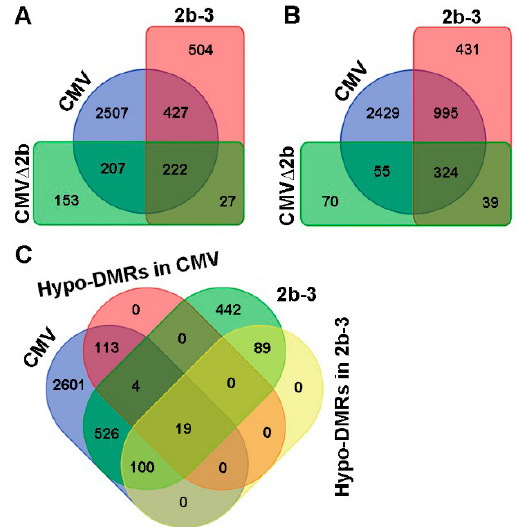
Figure 3. Compared to Col-0, the differentially expressed genes in CMV-, CMV ∆ 2b- and 2b-3 plants. ( A ) The induced genes were detected concurrently in CMV-, CMV ∆ 2b- and 2b-3 plants. ( B ) The suppressed genes were detected concurrently in CMV-, CMV ∆ 2b- and 2b-3 plants. ( C ) The induced genes correlated with Hypo-DMRs in CMV- and 2b-3 plants.